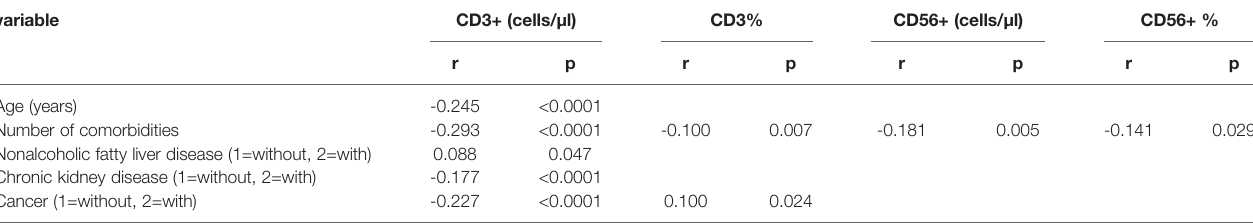
TABLE 3 | Spearman correlation analysis of lymphocyte subsets, age, sex, duration, geographical source of infection and comorbidities (n = 718).